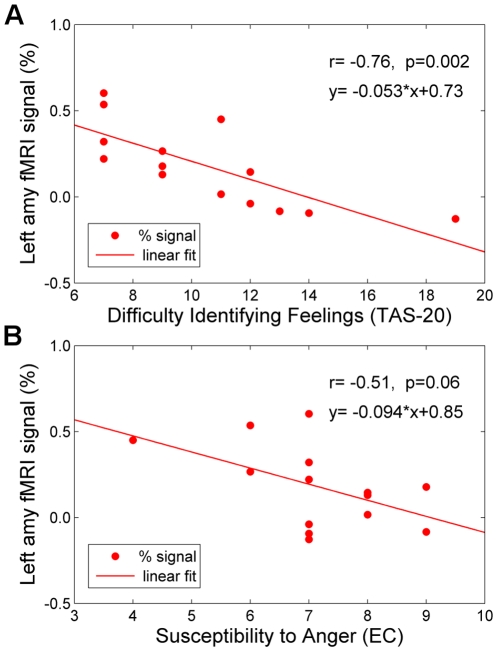
Relationship between the Neurofeedback Training Effect on the Left Amygdala Activation and Individual Psychological Scores.
A) Correlation with the Difficulty Identifying Feelings (TAS-20). The training effect for the left amygdala was correlated with the participants' insight into their feelings. Thus the more highly the participants rated their capacity for identifying their own feelings (based on the Difficulty Identifying Feelings sub-scale of the Toronto Alexithymia Scale, TAS-20), the more they increased the BOLD signal in the left amygdala during training. B) Correlation with the Susceptibility to Anger (EC). The higher the participants rated their sensitivity to other peoples' anger (based on the Susceptibility to Anger sub-scale of the Emotional Contagion scale, EC), the less BOLD activation was observed in their left amygdala during training. The activation levels shown (in both A and B) are averages across the three neurofeedback training runs (Runs 1–3) for each subject in the Experimental group.